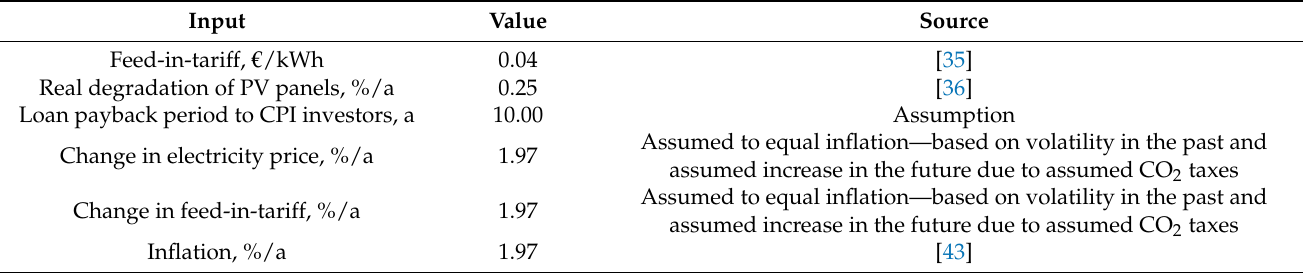
Table 1. Input feasibility